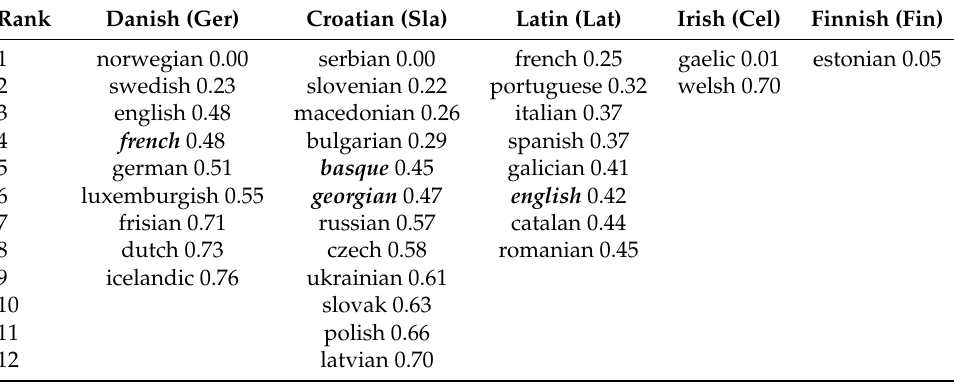
Table 1. Languages most similar to one representative of each of the well-known European families: Germanic (ger), Slavic (sla), Latin (lat), Celtic (cel), and Finno-Permic (fin) using ALD measure. The test was performed with ALD on 7-grams and linear